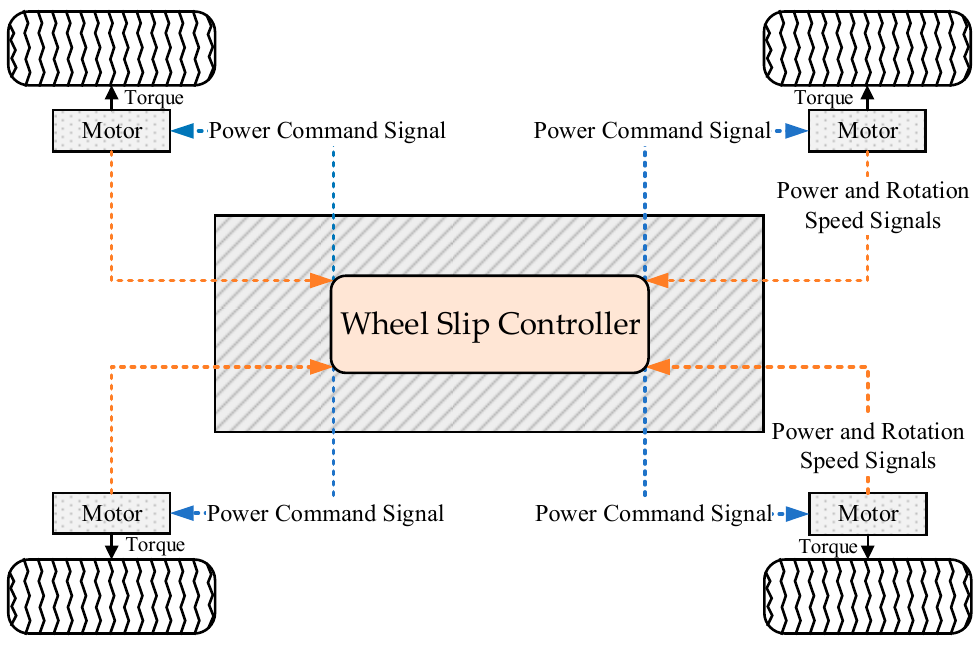
Figure 3. Chassis and wheel slip control system layout.